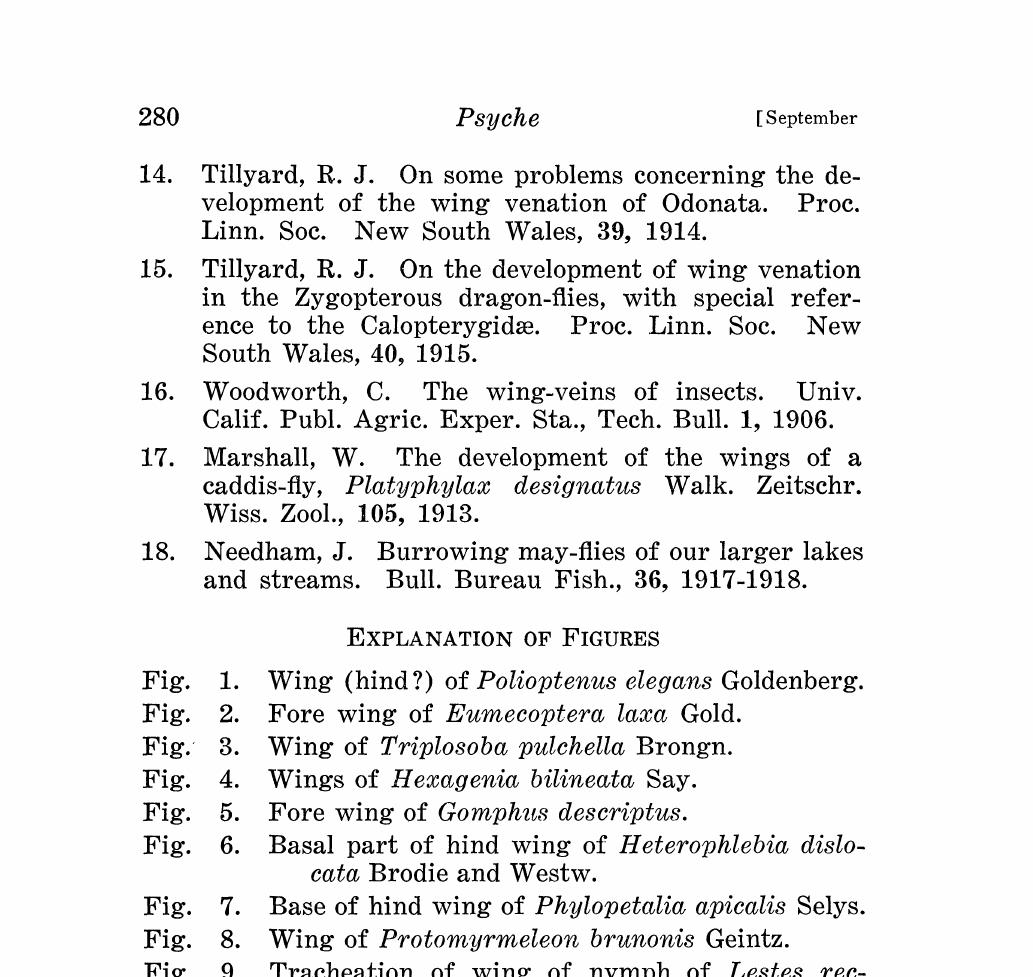
Fig. 1. Wing (hind ?) o Polioptenus elegans Goldenberg. Fig. 2. Fore wing of Eumecoptera laxa Gold. Fig. 3. Wing of Triplosoba pulchella Brongn. o Hexagenia bilineata Say. Fig. 4. Wings Fig. 5. Fore wing of Gomphus descriptus. Fig. 6. Basal part of hind wing of Heterophlebia dislo- cata Brodie and Westw. Fig. 7. Base of hind ving of Phylopetalia apicalis Selys. Fig. 8. Wing of Protomyrmeleon brunonis Geintz. o Lestes rec- Fig. 9. Tracheation of wing of nymph tangularis Say. Fig. 10. Hind wing of Oliv., ater Eaton (5). ore wing in Fig. 11. Tracheation of the an’rage of the the adult nymph of a member of the Hexa- genioidea Ulm. (original). Fig. 12. Anormalous tracheation in the hind wing anlage ot a nymph of ,ZEschna sp. (original). Figures 1, 2, 3, 6, and 8 after Handlirsch (6) Fig. 4 after Needham (8); Figs. 5, 7, and 9 after Need- ham